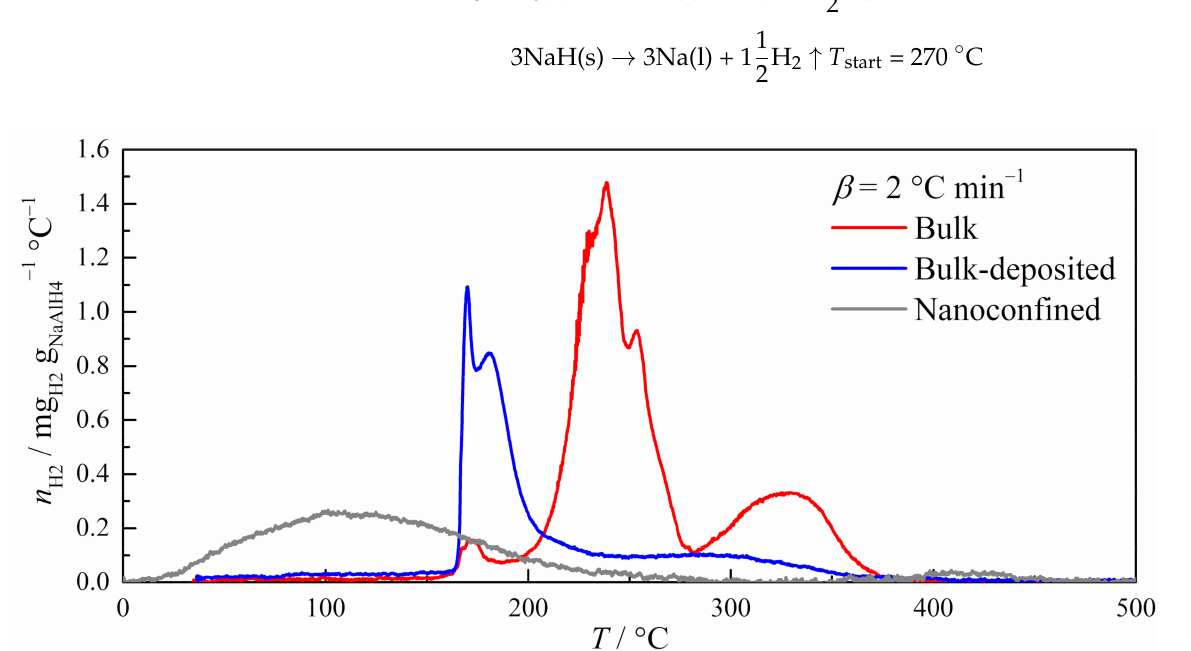
Figure 1. Hydrogen release curves of different forms of NaAlH 4 (noted in the figure) measured at a constant temperature ramp rate, β , of 2 ◦ C min − 1